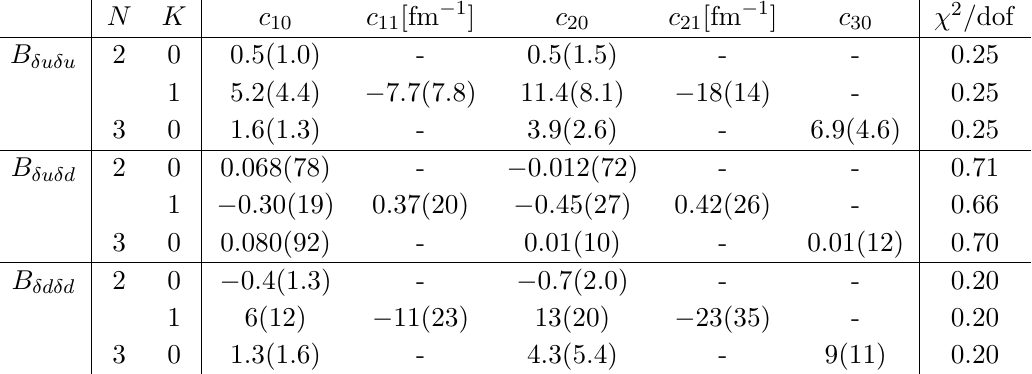
Table 11 . The same as table 7, but for the twist-two function B δqδq 0